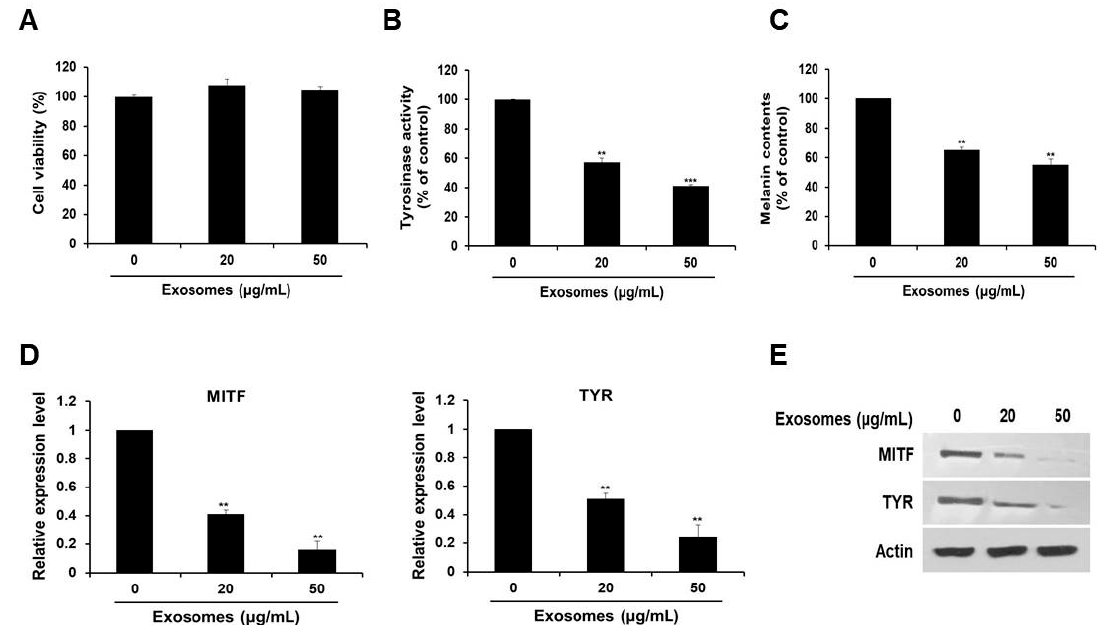
Figure 2. Milk exosomes reduce melanogenesis in mouse B16F10 cells. Cells were cultured with 20 or 50 µ g/mL of exosomes for 48 h. ( A ) Cell viability was measured by a WST assay. ( B ) Tyrosinase activity was assessed after treatment with milk exosomes; n = 3, ** p < 0.01, *** p < 0.001. ( C ) Melanin contents were determined in the cells exposed to milk exosomes; n = 3, ** p < 0.01. ( D ) MITF and TYR mRNA levels in milk exosome-treated cells were measured by qRT-PCR; n = 3, ** p < 0.01. ( E ) Levels of the proteins MITF and TYR in cells treated with milk exosomes were examined by Western blotting. To investigate the possible skin cell-whitening effect of milk exosomes, cells were treated with milk exosomes. We found that tyrosinase activity in cells exposed to milk exosomes at concentrations of 20 or 50 μ g/mL diminished by 43% and 59%, respectively